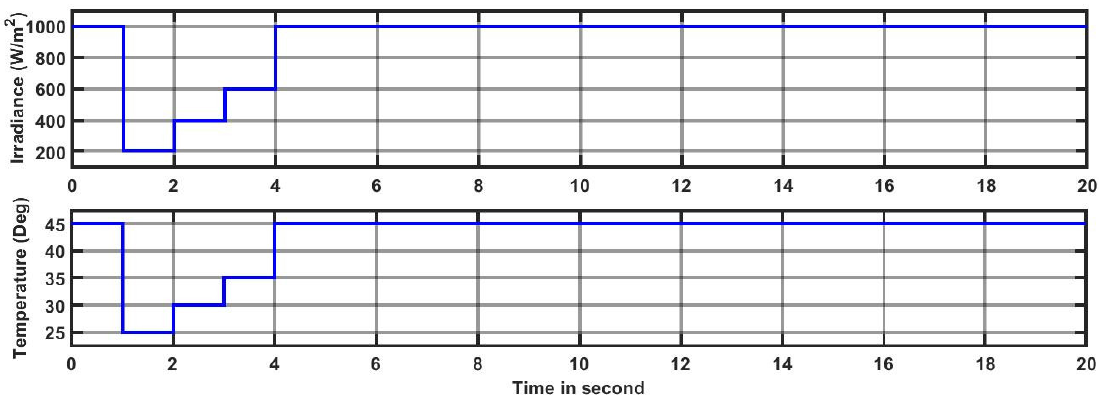
Figure 10. Variations in Jali PV module parameters with irradiance and temperature.